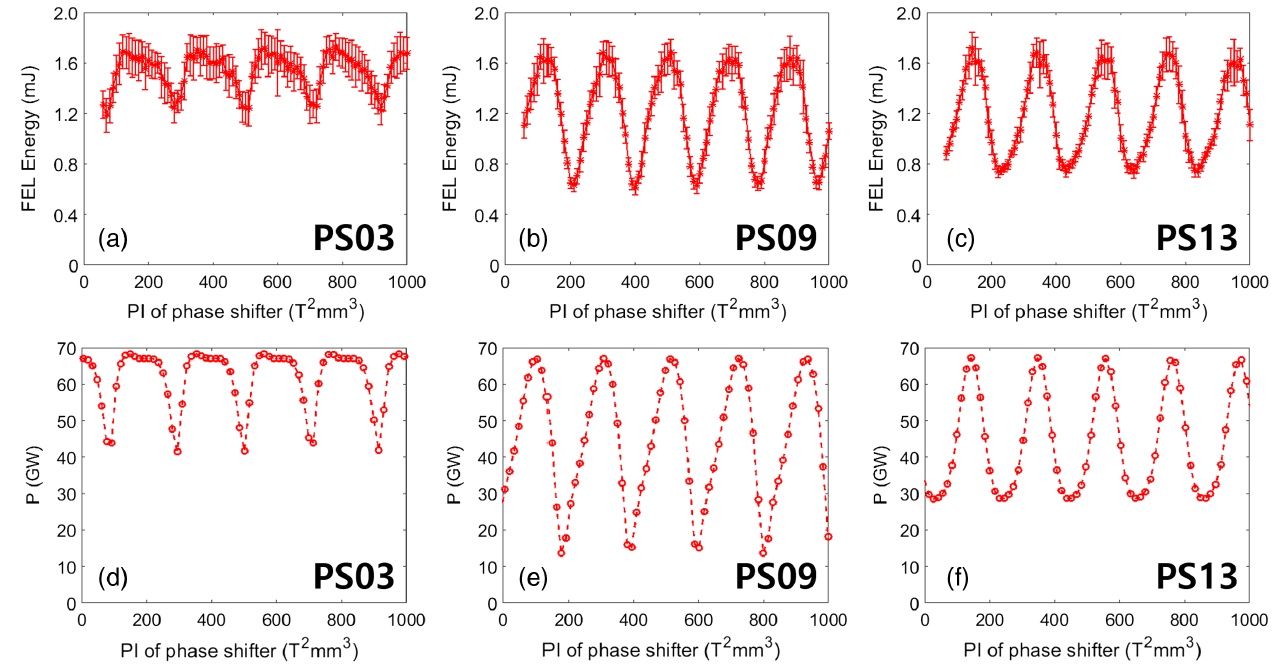
FIG. 4. (a) – (c) Measured FEL intensity at the QBPM (bars, (cid:4) 1 s : d : ; n ¼ 100 ) and (d) – (f) FEL intensity obtained from GENESIS simulation as a function of the phase integral of phase shifter at 18 (PS03), 54 (PS09), and 78 m